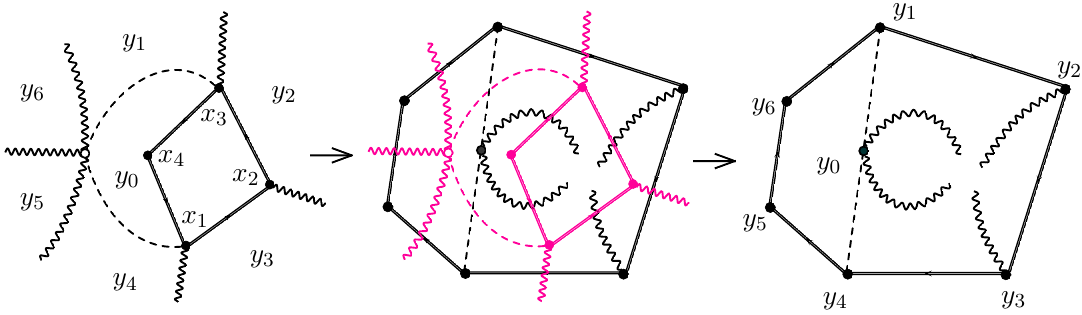
Figure 4 . Diagrammatic representation of the duality relation W (0 , 0)